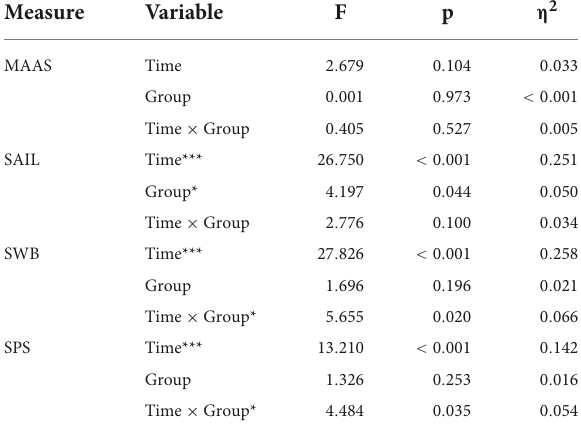
TABLE 2 ANOVA results.